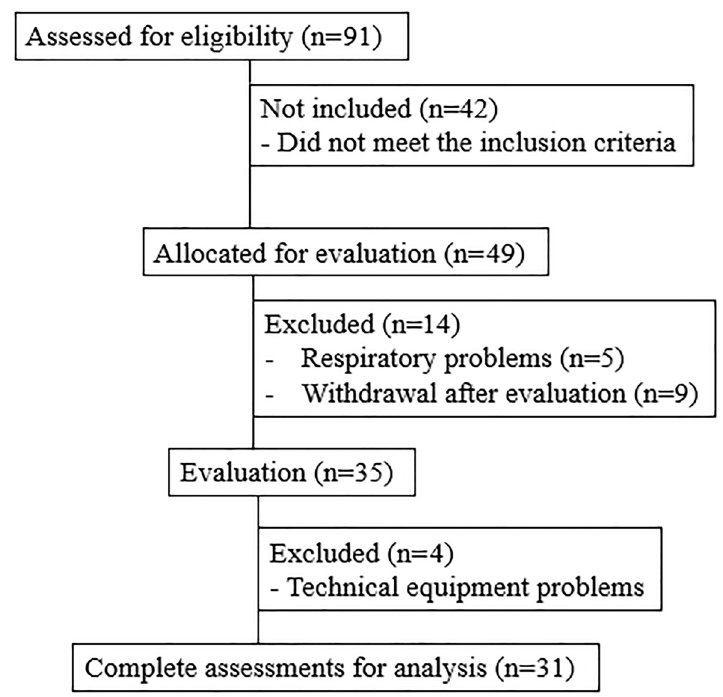
Figure 1. Flowchart of the individuals who partici- pated in the study.